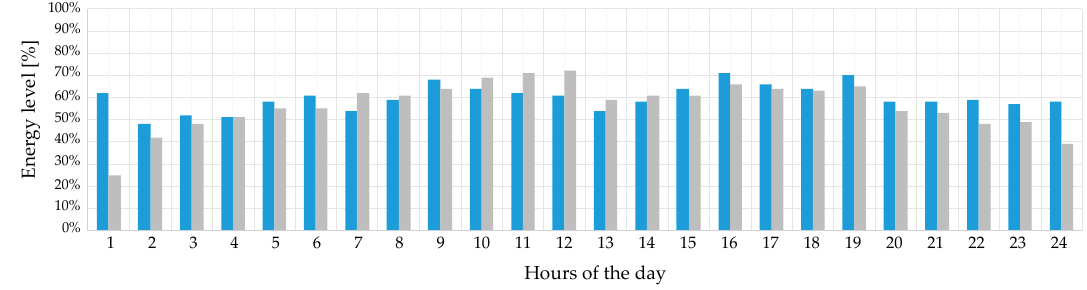
Figure 10. BESS charging/discharging profiles.